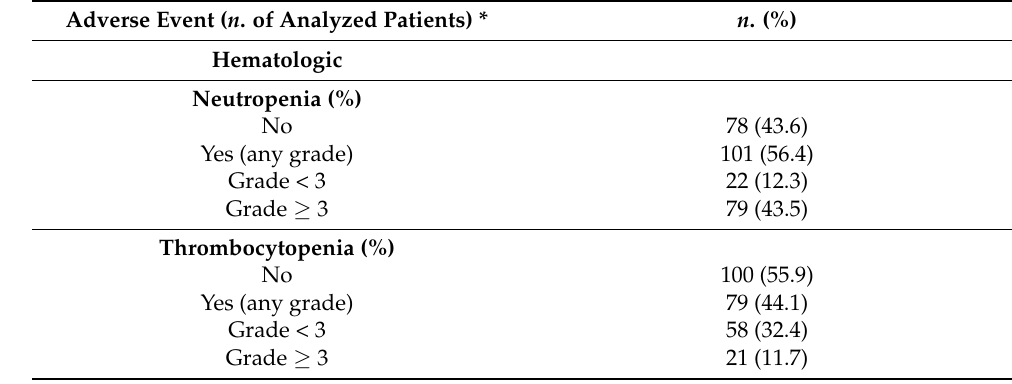
Table 3. Acute and late toxicities. Details on hematologic, extra-hematologic toxicity and long term complications (secondary neoplasia) after bendamustine-based therapy. Abbreviations: UTI, urinary tract infections, CMV, cytomegalovirus, VZV, varicella zoster virus. Adverse Event ( n . of Analyzed Patients)